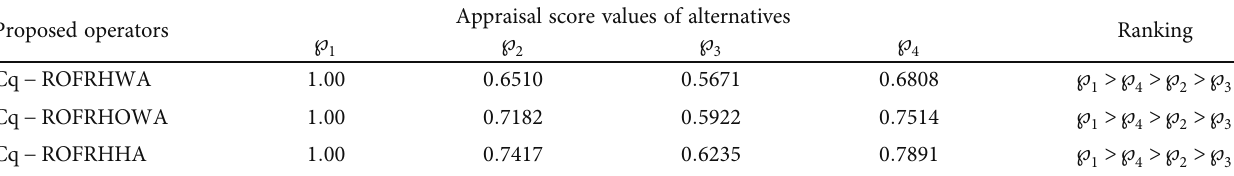
Table 9: Score value and their